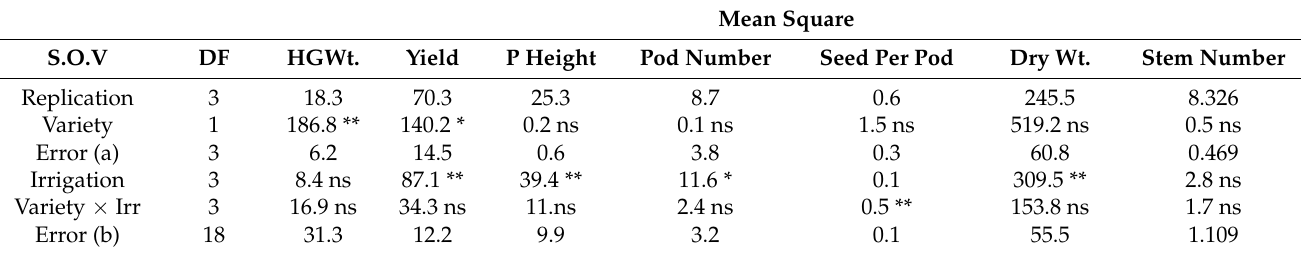
Table 2. Analysis of variance on plant growth parameters of bean varieties in irrigation